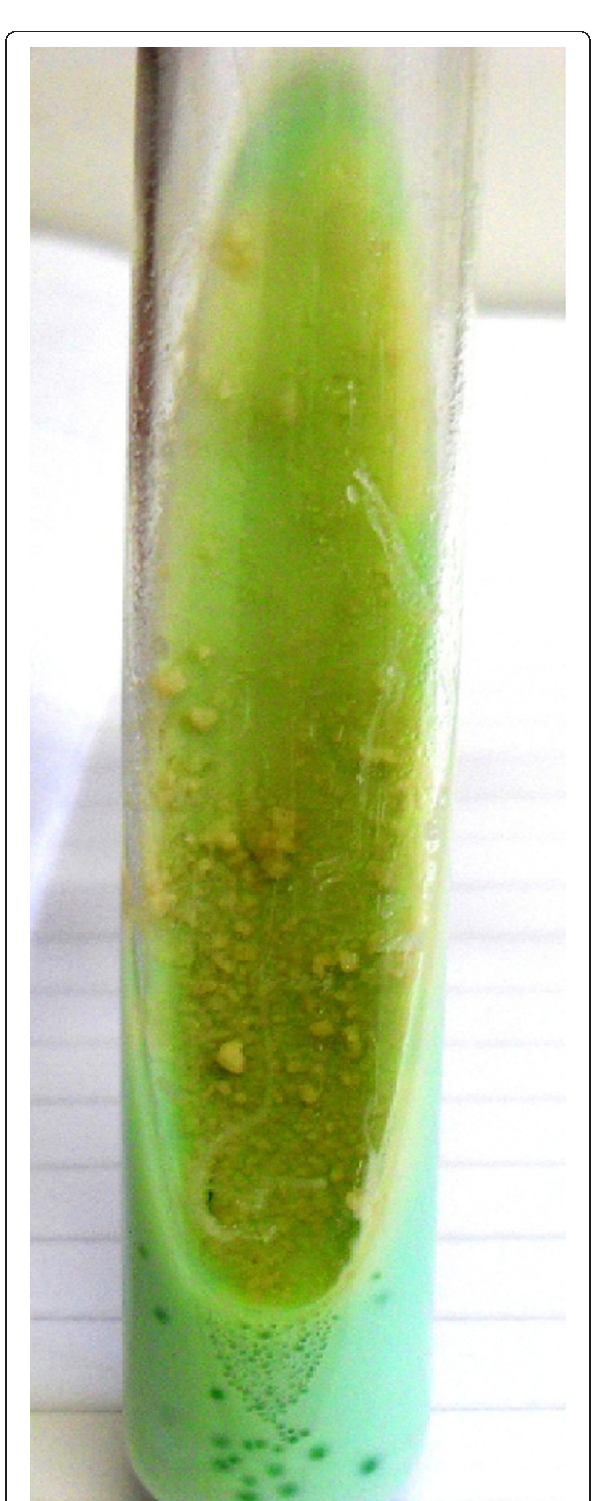
Figure 6 M. tuberculosis, positive culture on Löwenstein-Jensen medium at